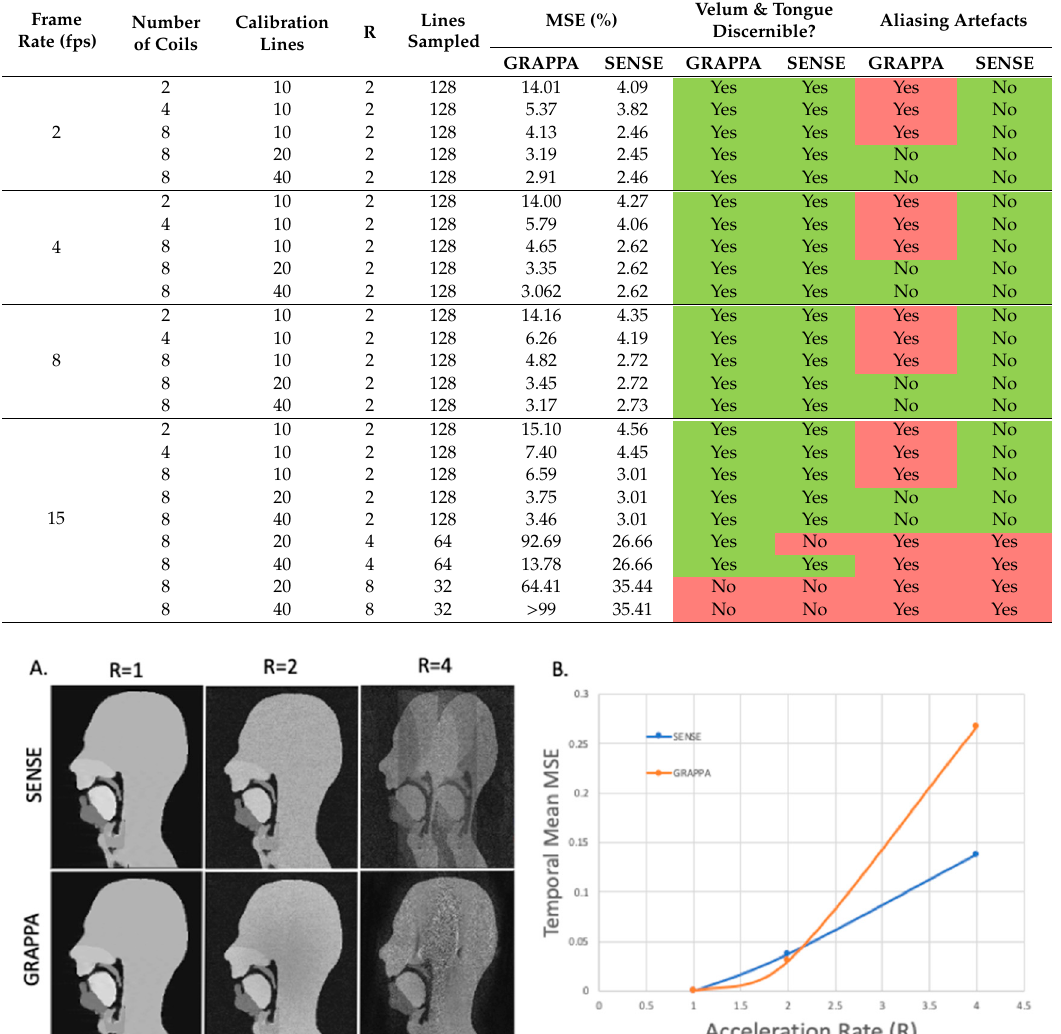
Table 1. SENSE and GRAPPA reconstructions of undersampled multi-coil images simulated from a dynamic speech phantom. Green shading indicates that the reconstructed images passed a given subjective fidelity criterion, whilst red shading indicates a failed subjective fidelity criterion.